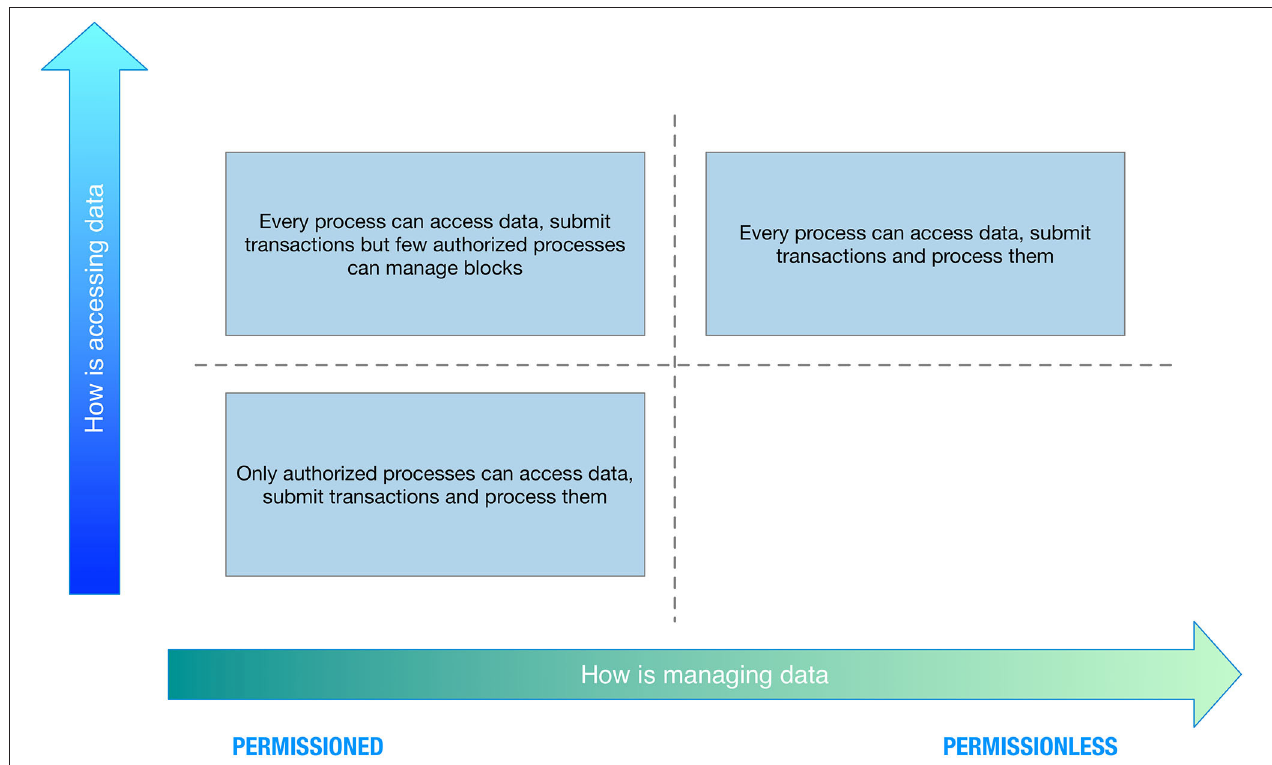
FIGURE 3 | Blockchain classification